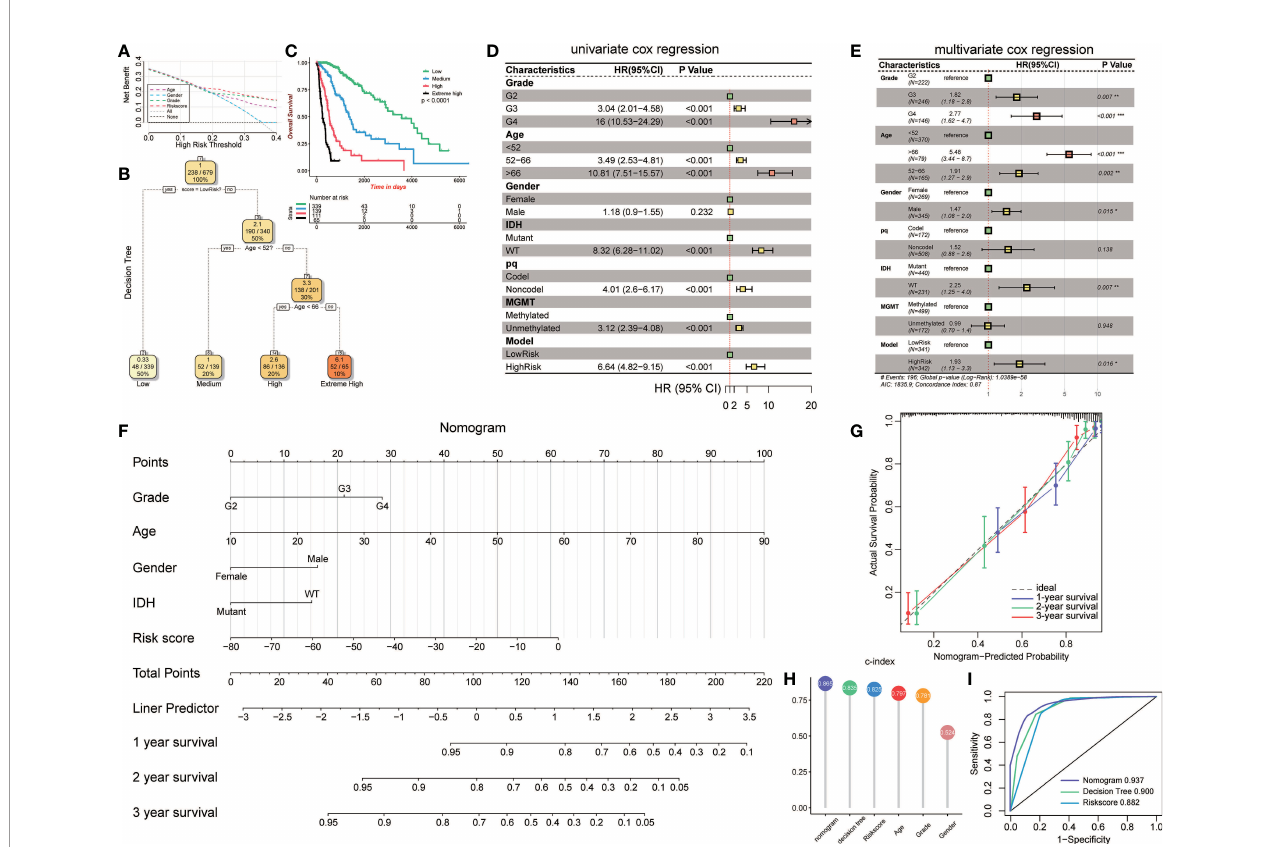
FIGURE 7 | Construction and validation of the clinic-associated model. (A) Decision curve analysis (DCA) for age, gender, grade, and risk score, revealing the risk score revealed better survival outcomes than the other variables. (B) Patients with risk score and age were used to set up a detailed glioma risk strati fi cation. (C) Kaplan-Meier survival analysis of the four precise risk subtypes in the TCGA dataset. (D) Forest plot of the univariate Cox proportional-hazards model survival analysis of various parameters. (E) Forest plot of multivariate Cox proportional-hazards model survival analysis of various parameters. (F) Details of the nomogram. (G) Calibration curve showing a high accuracy of the nomogram. (H) Comparison of the predictive power of multiple models. (I) ROC curve of the nomogram, decision tree, and risk score model in 1 year. HR, hazard ratio; CI, con fi dence interval. *p<0.05; **p<0.01; ***p <0.001.